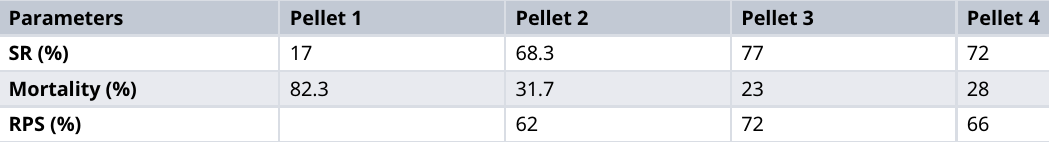
Table 4. Rate of survival, death and relative percentage of survival of goldfish at Week 12 after challenge test against A. hydrophila and P. fluorescens bacterial infection.